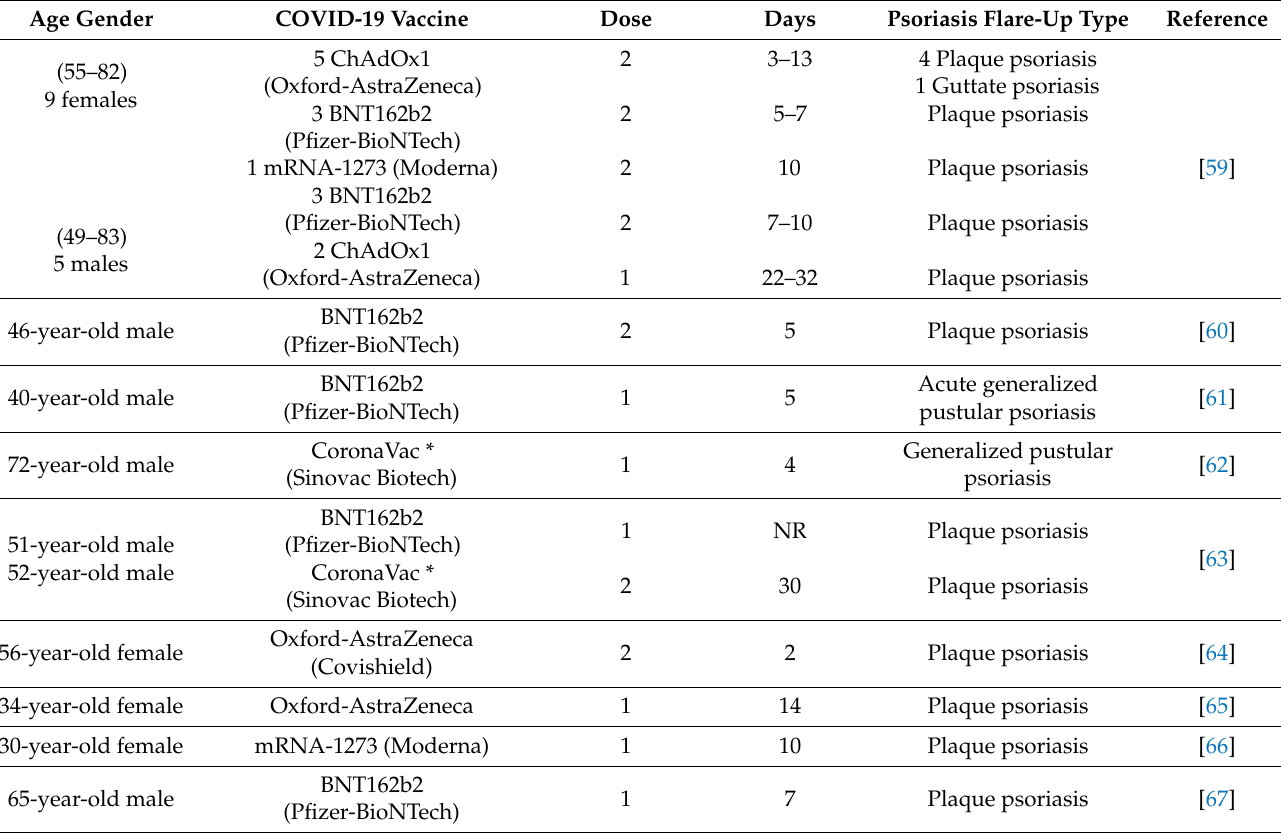
Table 2. A summary of cases reporting psoriasis exacerbation following anti-SARS-CoV-2 vaccination. Age